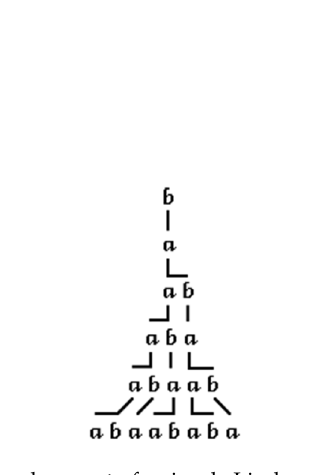
Figure 1. Classic five-step development of a simple Lindenmayer-System (L-System) [22].